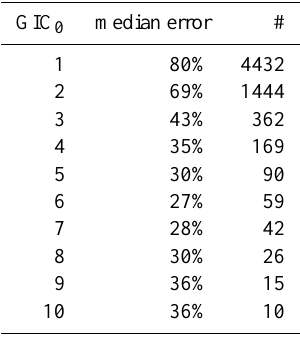
Table 9. As Table 8, but the magnetic field at Hankasalmi was used to calculate the electric